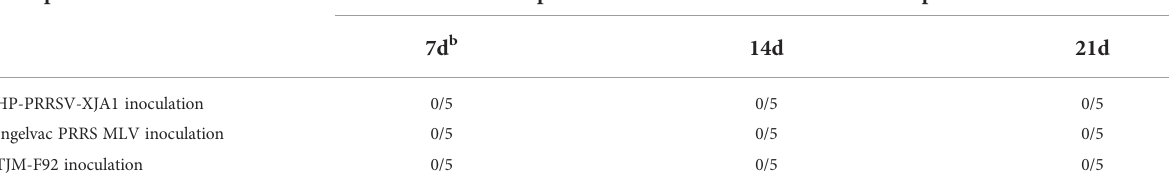
TABLE 2 Evaluation of pGM-CSF level of serum samples inoculated witgh different PRRSV by Double Antibody Sandwich ELISA. Groups